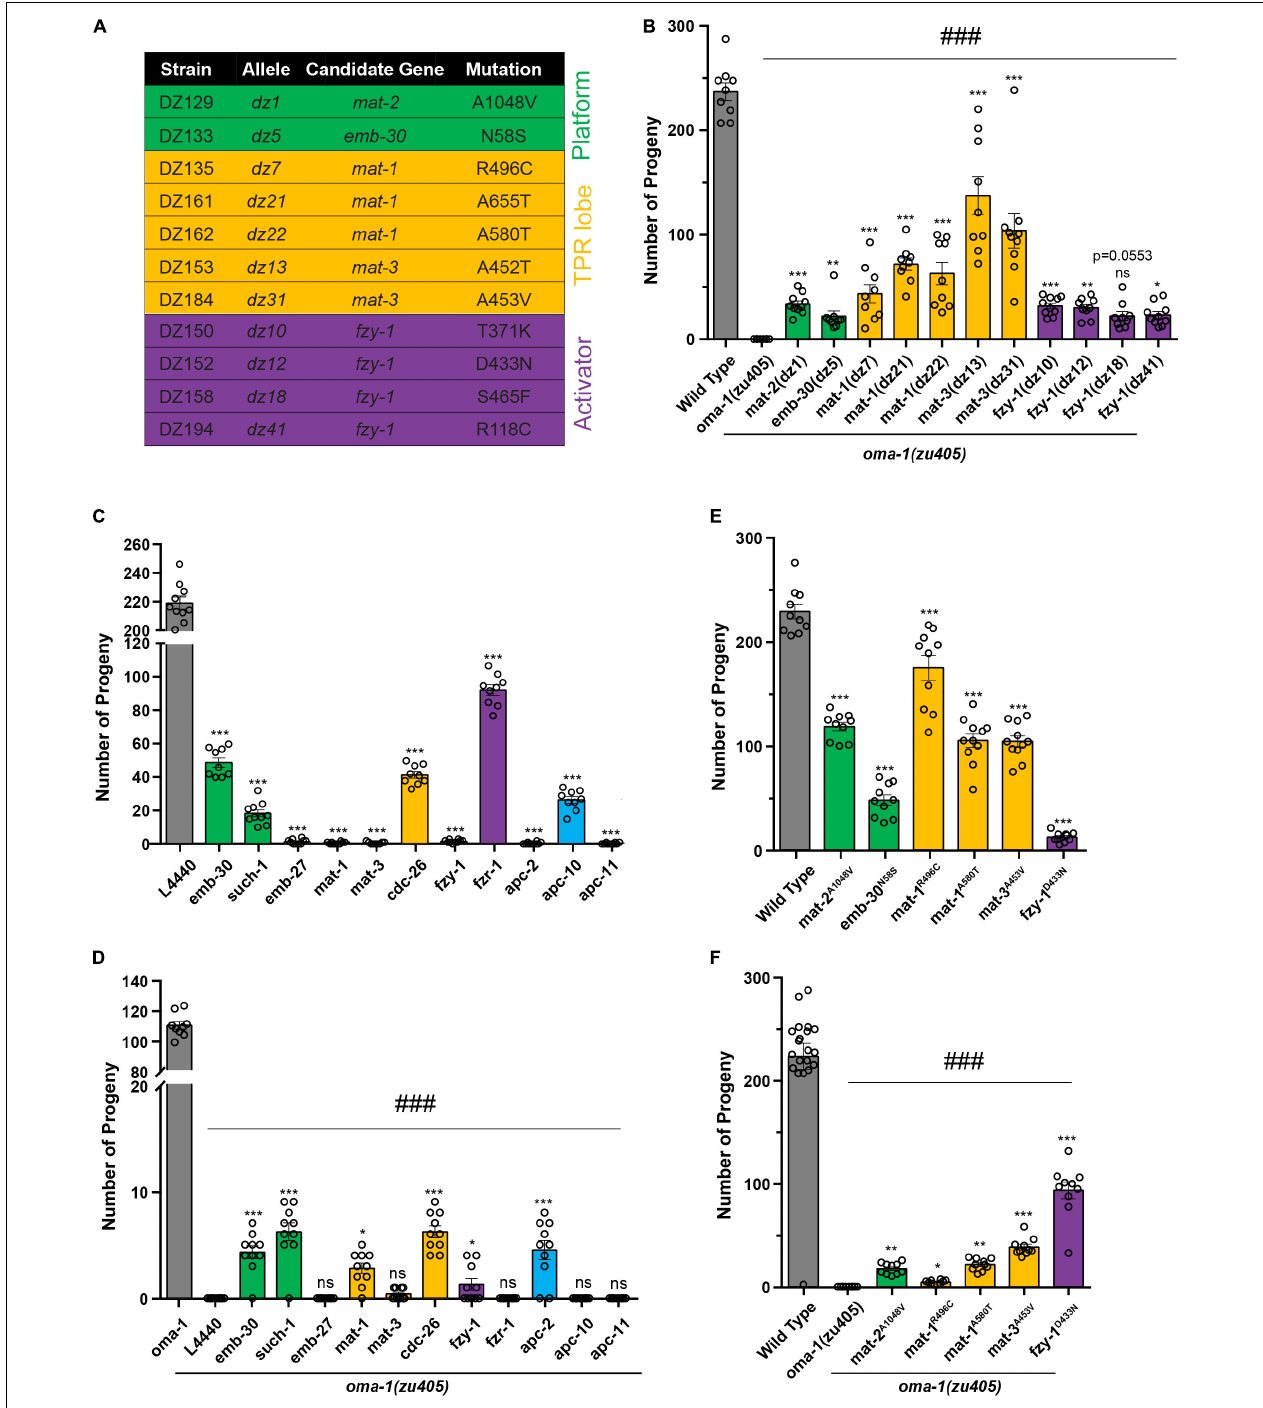
FIGURE 2 | Mutations in APC/C genes suppressed lethality of the oma-1(zu405) mutant. (A) Summary of potential mutations in APC/C genes identified from the suppressor screen. Genes encoding for platform subunits, TRP lob subunits, and activators are highlighted in green, yellow, and purple, respectively. (B) Brood size of mutants identified from the suppressor screen of the oma-1(zu405) mutant. (C) Brood size of strains treated with RNAi of corresponding APC/C genes in the wild type N2. L4440 expressed an empty RNAi vector, which served as the control. (D) Brood size of strains treated with RNAi of corresponding APC/C genes in the oma-1(zu405) mutant. L4440 expressed an empty RNAi vector, which served as the control. (E) Brood size of strains contacting point mutations in APC/C genes generated by the CRISPR/Cas9 gene editing system. It should be noted that these point mutations were identified in mutants from the suppressor screen. (F) Brood size of oma-1(zu405) combined with corresponding point mutations in APC/C genes. The results are presented as the average ± S.D. with individual values plotted. * p < 0.05; ** p < 0.01; ***, ### p < 0.001; ns: not significant. The p -values were calculated by 1-way ANOVA followed by Dunnett’s multiple comparisons. N = 10–15.